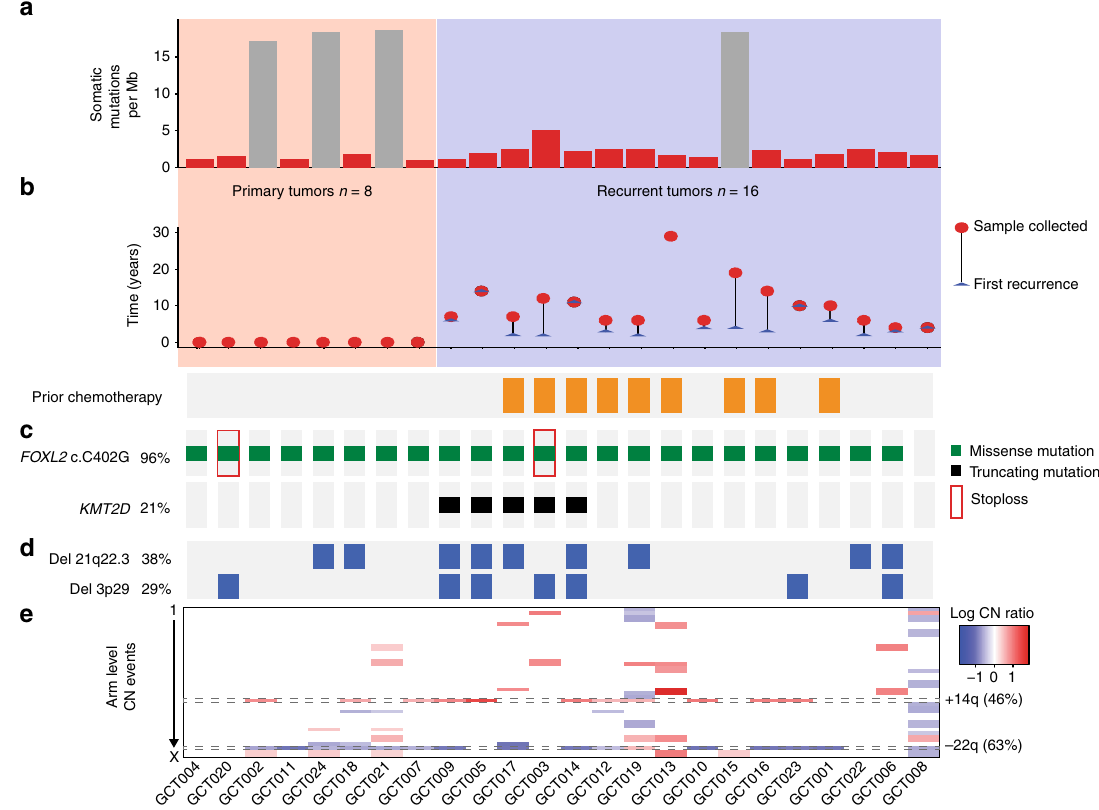
Fig. 1 Mutational landscape of primary and recurrent aGCTs. a Somatic mutation rate per megabase (Mb) for primary ( n = 8) and recurrent ( n = 16) aGCTs. Gray bars indicate samples with no matched normal tissue, for which the mutation rate may be in fl ated by the inclusion of rare SNPs. b Time in years between diagnosis, fi rst recurrence (blue arrow), and sample collection (red circle). The receipt of cytotoxic chemotherapy at any time between diagnosis and sample collection is indicated by an orange box. c Signi fi cantly mutated genes in aGCT. d Signi fi cantly recurrent focal CNVs. e Recurrent arm-level CNVs. Heat map indicates log CN ratio for CNV event. Mb: megabases, CN: copy Table 1 Somatic KMT2D -truncating mutations detected in sequenced aGCT cohorts Sample Cohort Platform FOXL2 c.C402G hotspot